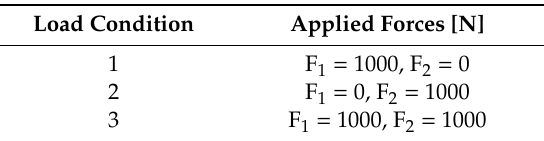
Table 2. Load pattern description.